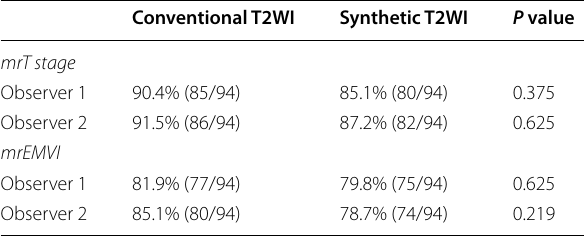
Table 4 Comparison of diagnostic accuracy of T stage and EMVI using conventional and synthetic T2WI